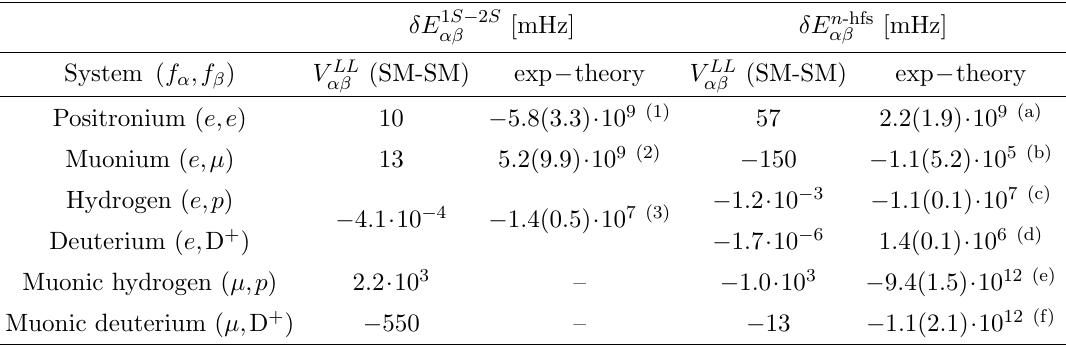
Table 2 . Predicted shifts to the 1 S (cid:0) 2 S and hyper(cid:12)ne splittings of two-body systems ( f (cid:11) ; f (cid:12) ) due to the SM-induced neutrino-mediated potential V LL ( r ). The potential is mediated by three (cid:11)(cid:12) light active neutrinos with m 1 = 0 : 1 eV and the other masses and mixings determined in the NO case. Where possible we compare these to the di(cid:11)erences between the experimentally-measured and theoretically-predicted values for these splittings. Uncertainties in these values are calculated by adding the experimental and theoretical uncertainties in quadrature. References for experimental and theoretical values are given in the footnotes below the table respectively. mainly due to the cut-o(cid:11) r = 1 =m being two orders of magnitude smaller than the charge c Z